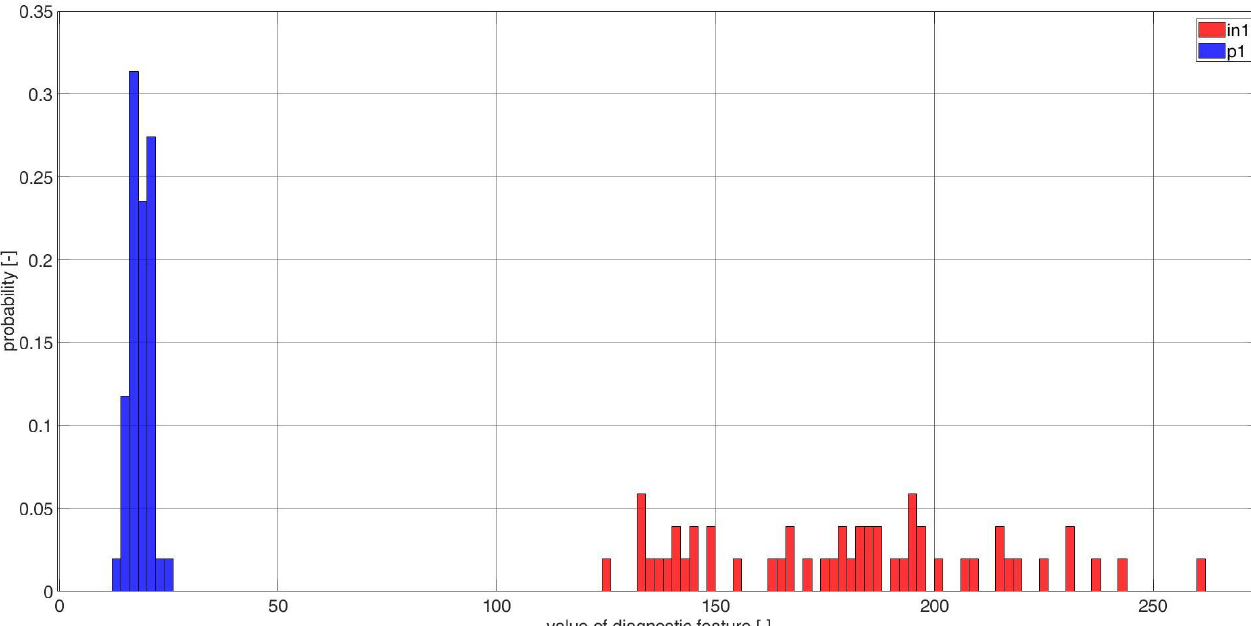
Figure A12. Histograms of diagnostic features based on the CCSM3 (correlation number is 12 — Table A1) bearings in2 and p2.